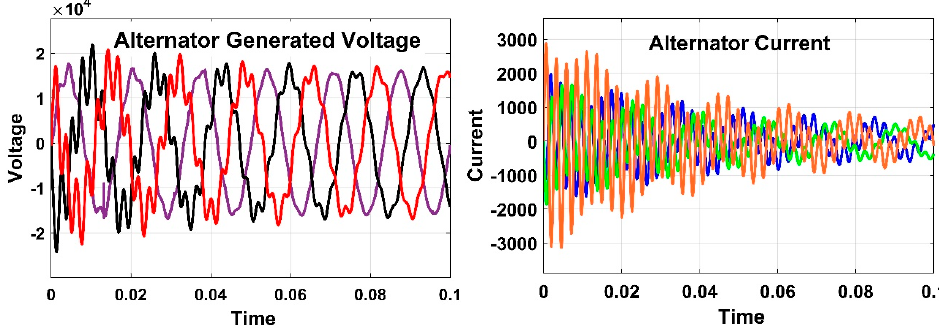
Figure 4. Generated voltage and current of alternator.